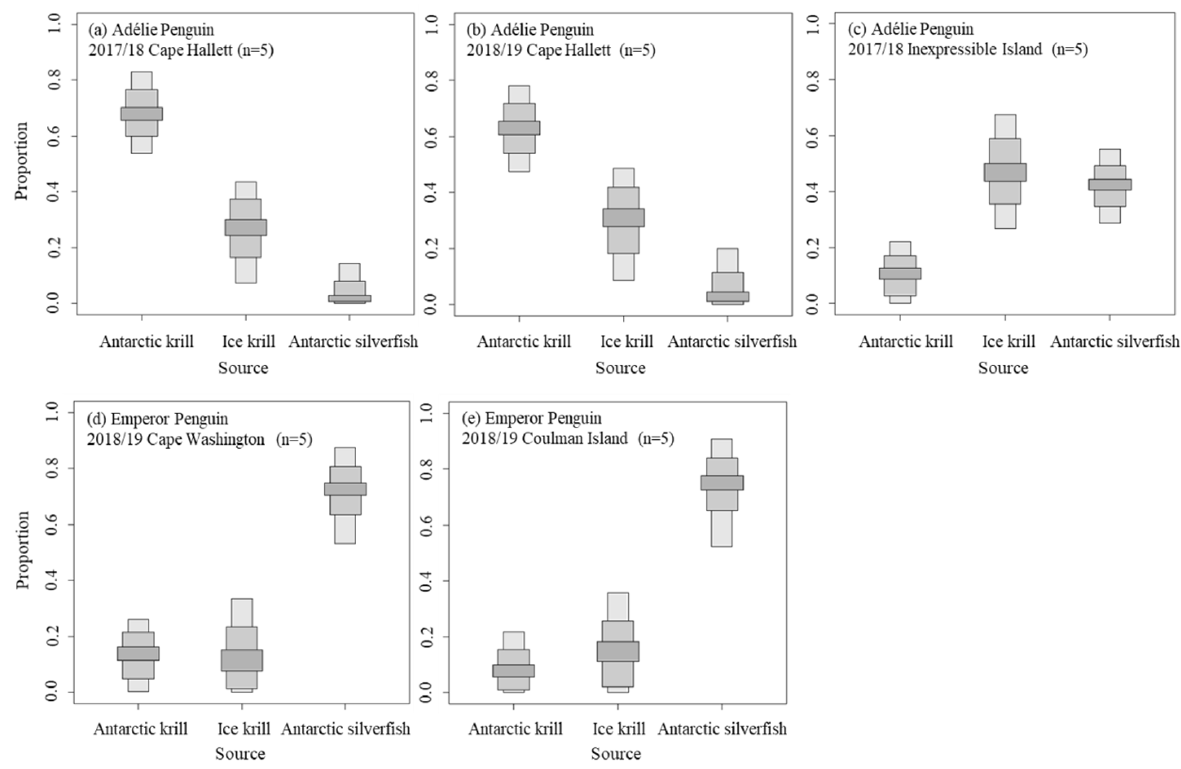
Figure 3. Proportion of main prey (Antarctic krill, ice krill, and Antarctic silverfish (%)) in the diets of Adélie Penguin chicks ( a – c ) and Emperor Penguin chicks ( d , e ). The gray bars of different widths from dark to light indicate the 95, 75, and 25% confidence intervals.